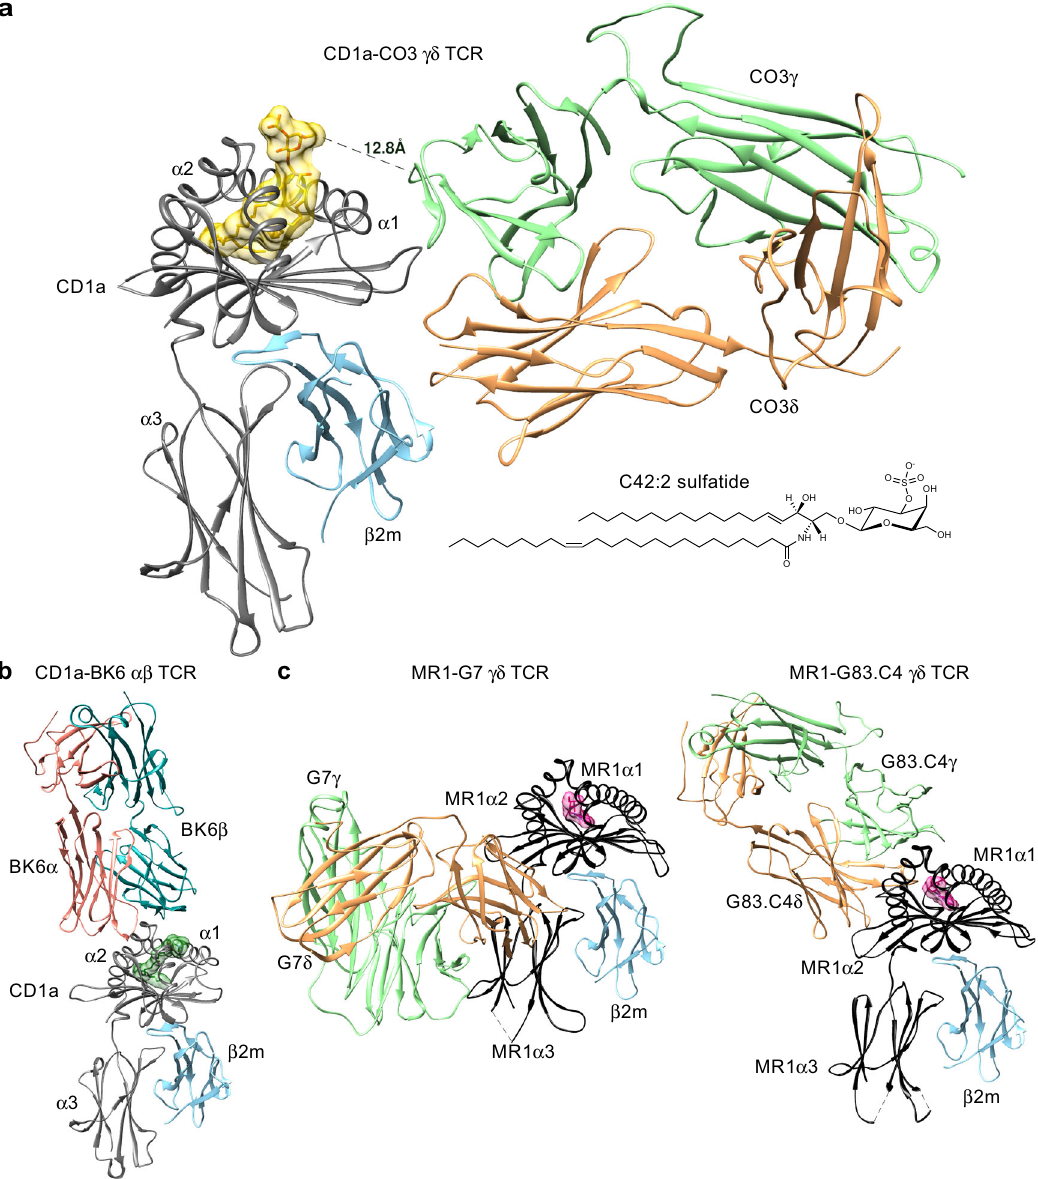
Fig. 3 CO3 γδ TCR binds CD1a in an unprecedent manner. a The overview of the crystal structure of CO3 γδ TCR-CD1a-sulfatide is shown. Both chains of the CO3 γδ TCR ( γ chain in green; δ chain in orange) docked on the side of CD1a (grey) - β 2m (blue) heterodimer forming a ~90° incident angle. The lipid antigen sulfatide (yellow) protrudes from the cleft of CD1a. The sideways docking mode is contrasted with b CD1a-restricted autoreactive αβ TCR BK6 ( α chain in coral, β chain in cyan, lipid ligand in dark green; PDB: 4X6C) and c the docking modes seen for MR1 restricted γδ TCRs: G7 (left: PDB 6MWR) and G83.C4 (right: 7LLI). MR1 is shown in black, γ chains are in green, δ chains in orange and the MR1 ligands in